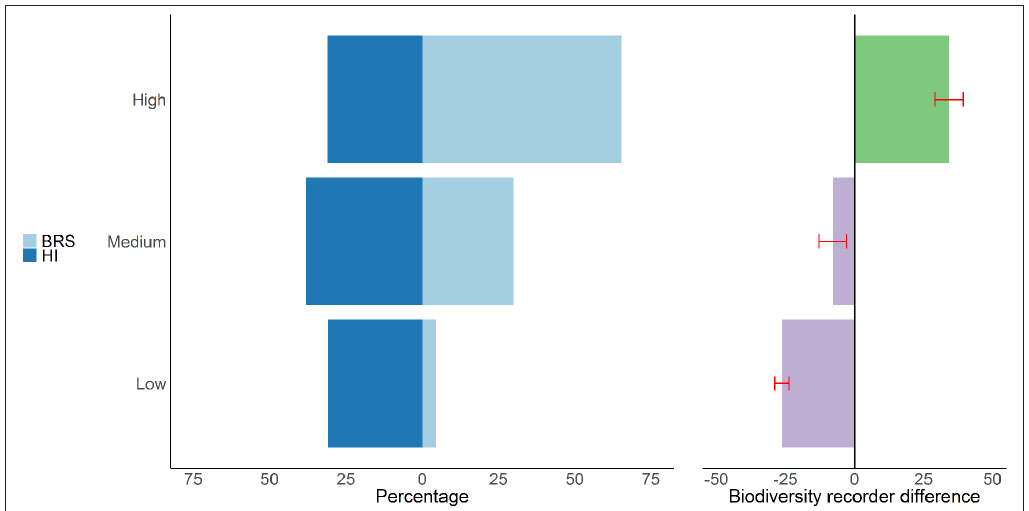
Figure 2: Highest education attainment of biodiversity recorders compared with adult population in Ireland using Healthy Ireland Survey (HI). Low indicates less than primary, primary, and lower secondary education; medium indicates upper secondary and post-secondary non-tertiary education; high indicates short-cycle tertiary, bachelors, masters, and doctoral education. 95% confidence intervals are based on difference in proportions tests.